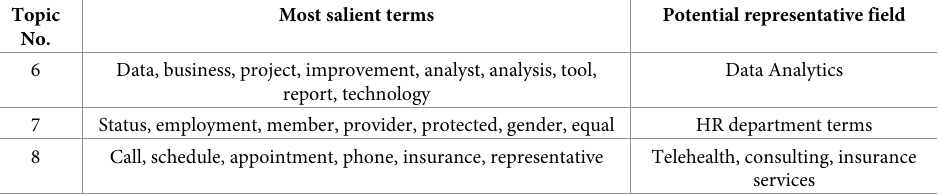
Table 4. UK data top three topics (Period 1). Topic